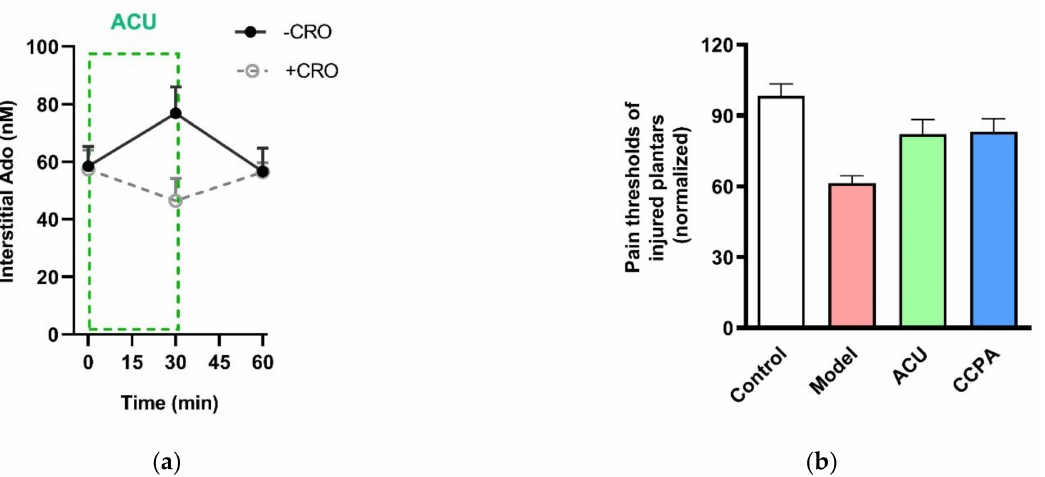
Figure 12. Contribution of Ado and A1 receptors to acupuncture analgesia. ( a ) Extracellular Ado level in response to 30-min needing in the absence and presence of CRO. Ado was collected with microdialysis method for each 30 min and assayed with high-performance liquid chromatogra- phy. CRO (0.02 g/mL, 20 µ L) was pre-injected in treated acupoints of rats 5 min before needling. ( b ) Changes of thermal pain thresholds of the injured plantars in response to acupuncture or acti- vation of A1 receptors. 2-Chloro- N 6-cyclopentyladenosine (CCPA) (0.04 mg/mL, 20 µ L), a specific agonist of A1 receptors, was injected in acupoint rats 30 min before behavioral tests. Establishing the inflammation pain and acupuncture intervention was referred to the legend of Figure 5. Data represent means + SEM ( n = 7–11) and are based on Huang et al. (2018)